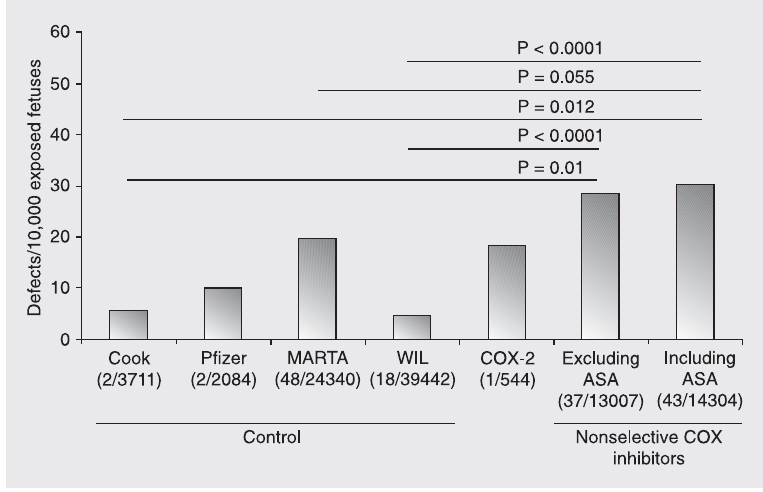
Figure 4. Incidence of ventricular septal defects in various historical control groups and groups prenatally exposed to selective cyclooxygenase (COX)-2 inhibitors, and nonselec- tive COX inhibitors in relation to aspirin (ASA). Pfizer, Middle Atlantic Reproduction and Teratology Association (MARTA) and WIL Research Laboratories, Inc. (WIL) control data are those reported by Cook et al. (17) and were not obtained directly from these sources. Data for selective COX-2 inhibitors include: DFU (16), DuP-697 (24) and CJ-19,209 (19). Data for nonselective COX inhibitors contain our own (Table 1) and Cappon et al. (19) findings, and all previous observations summarized by Cook et al. (17). The ratio (fetuses affected/total fetuses examined) is listed, with the source or drug group on the abscissa. Data were analyzed statistically by the two-sided Mantel-Haenszel